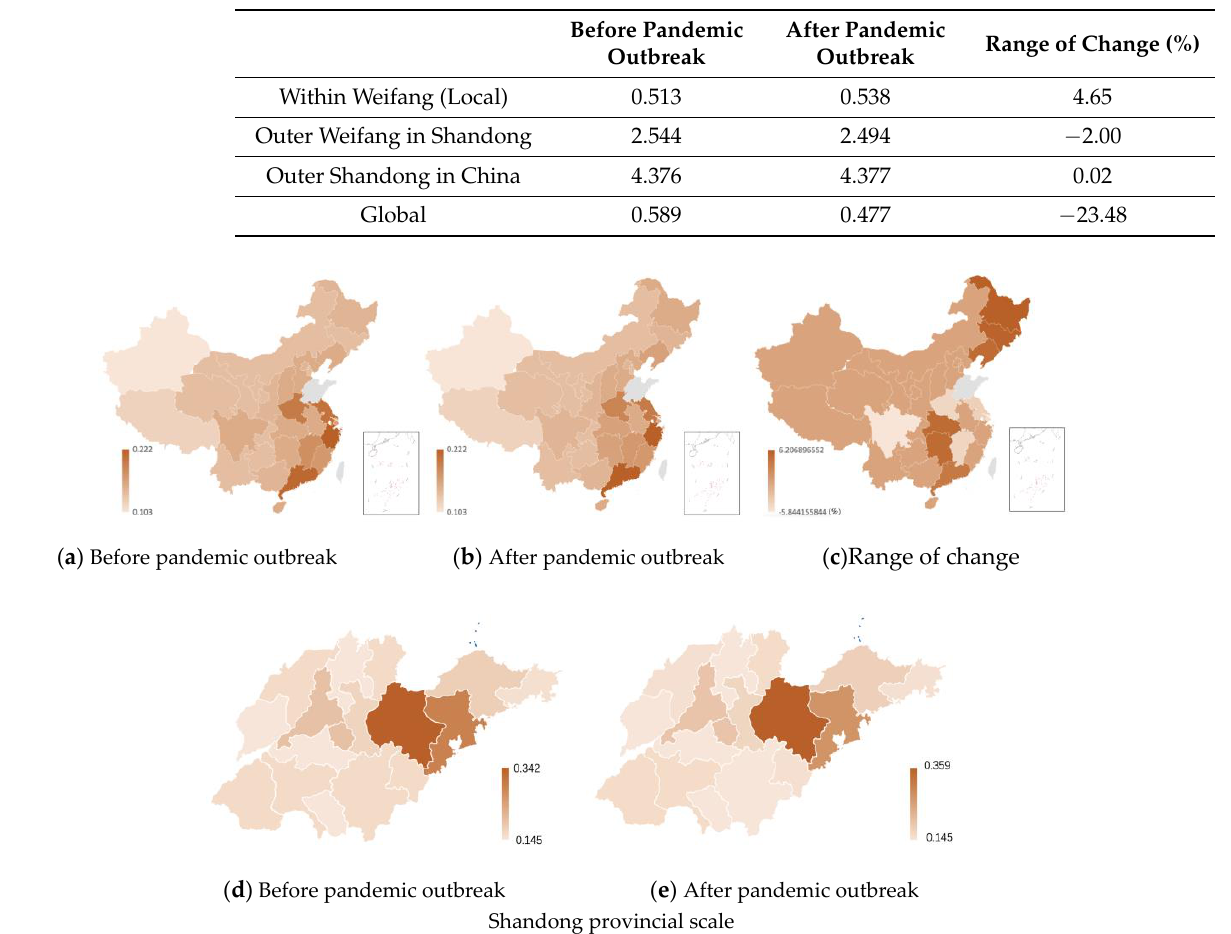
Figure 9. Spatial distribution of, and changes in, the degree centrality of sales destination nodes in firms’ sales logistics networks.